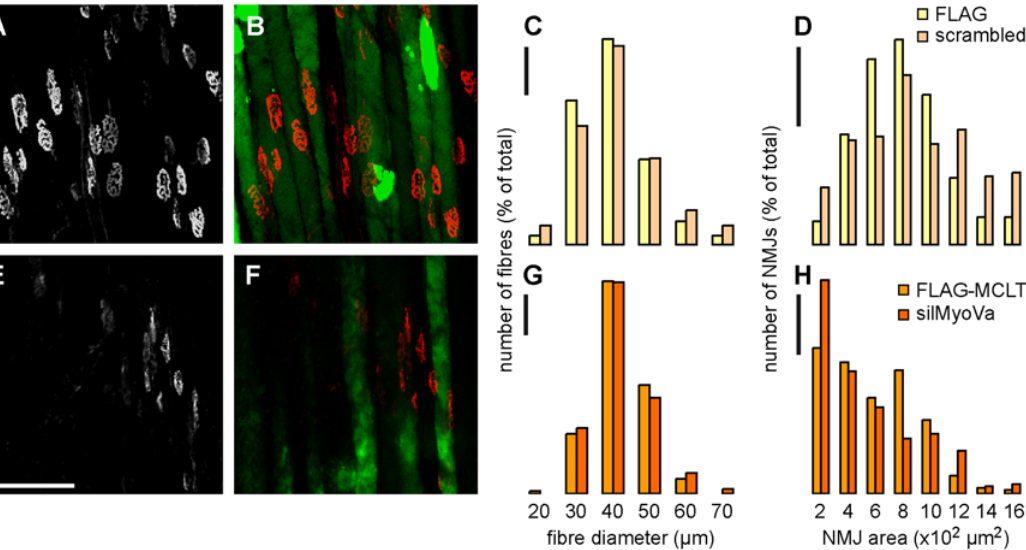
Figure 5. NMJs shrink upon transfection with FLAG-MCLT or silMyoVa in vivo. TA muscles of adult wildtype mice were co-transfected with cytoplasmic YFP and FLAG (A–D), FLAG-MCLT (E–H), scrambled silMyoVa (C–D) or silMyoVa (G–H). Ten days later, transfected muscles were locally injected with BGT-AF647 and imaged with in vivo confocal microscopy. A–B and E–F: Representative maximum z-projections of 74 and 64 optical slices in A–B and E–F, respectively, taken at 3 m m interslice distance. A and E: Signals of BGT-AF647. Scale bar, 200 m m. B and F: Overlay of BGT- AF647 (red) and cytoplasmic YFP (green). C–D and G–H: Histograms, fibre diameter distribution (C, G) or NMJ area distribution (D, H) for the same set of fibres. Scale bars, 10% of total amount of measured fibres or NMJs. For each condition, at least 202 fibres or NMJs from at least 4 different animals were analysed.